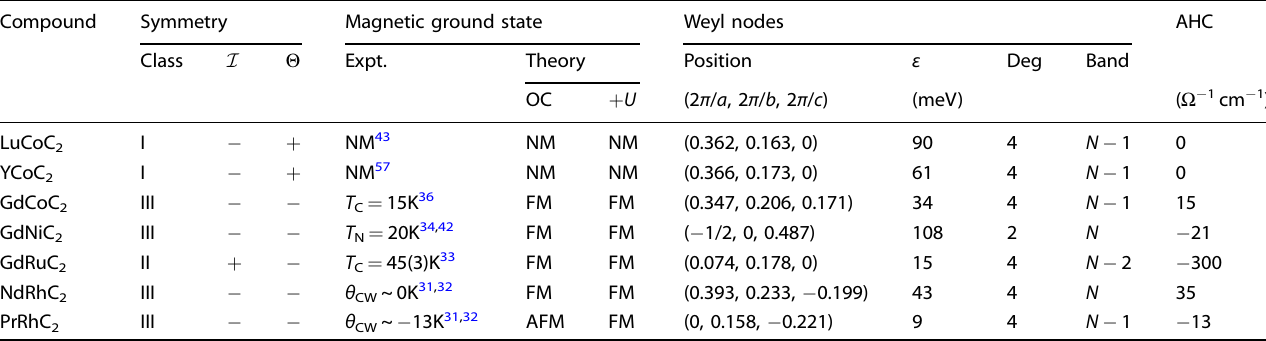
Table 1. Symmetry, magnetic ground state and, for the Weyl node closest to the Fermi energy, position, energy ( ε ), degeneracy (Deg) and band index of the lower branch in the band crossing ( N is the number of valence